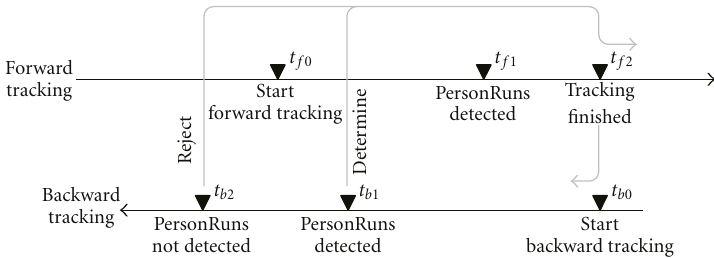
Figure 18: Timeline of backward tracking.